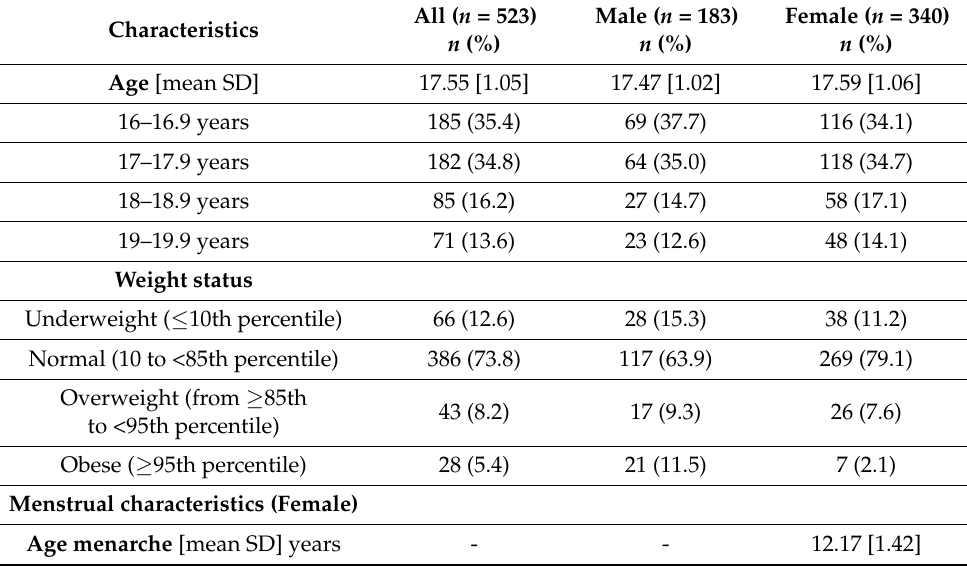
Table 1. Demographics and dietary characteristics of participants ( n =